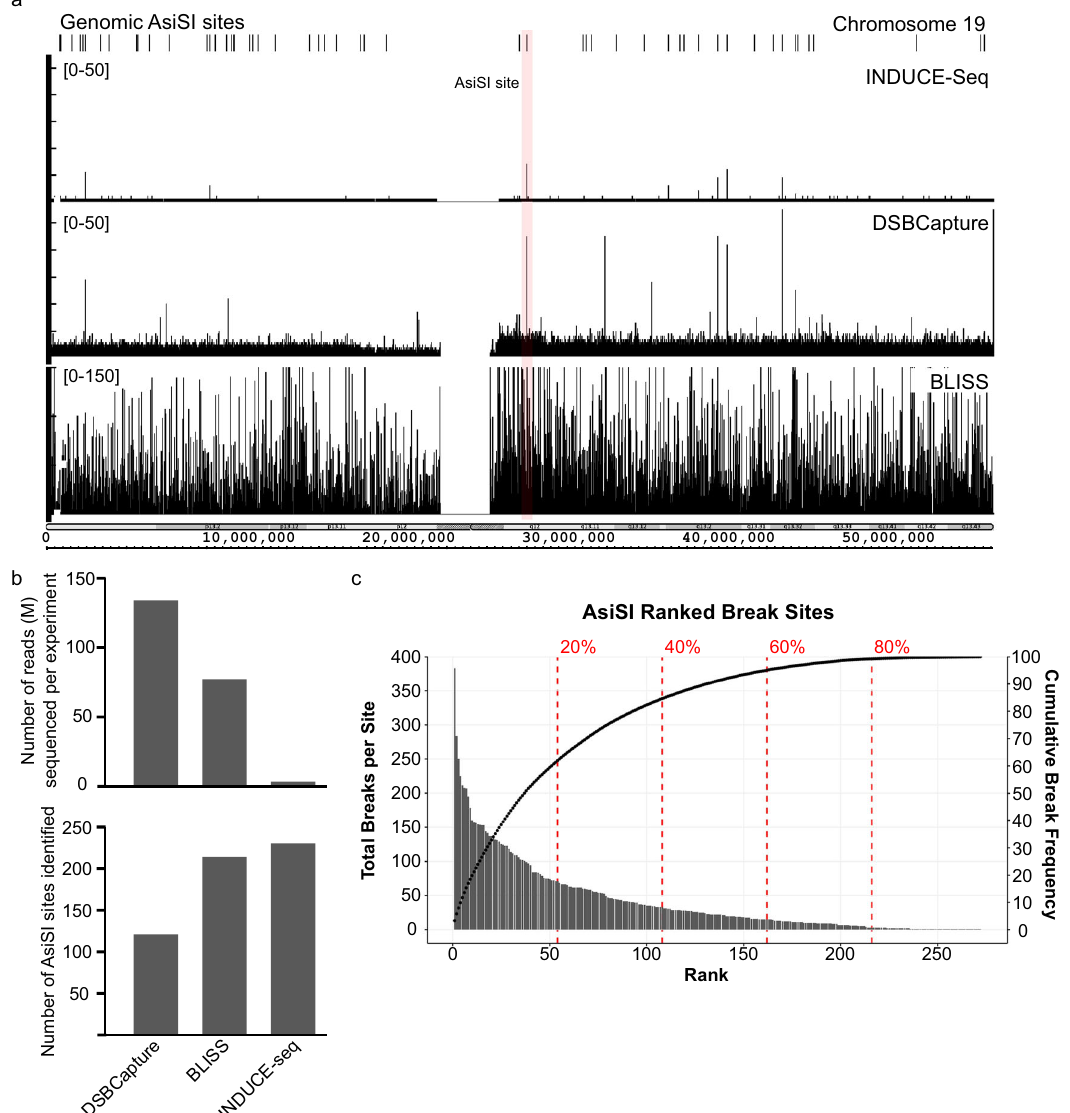
Fig. 3 INDUCE-seq reveals the characteristics of AsiSI site cleavage in live DIvA cells. a Genome browser view (IGB) comparing raw sequencing output of three different DSB capture methods used to detect induced breaks in live DIvA cells. The top panel indicates AsiSI recognition sequences present on chromosome 19. The second panel depicts the raw INDUCE-seq readout. The bottom two panels show the raw output of DSBCapture and BLISS. b Comparison between INDUCE-seq, DSBCapture and BLISS in detecting AsiSI-induced breaks in live DIvA cells. The number of reads sequenced ( b , top panel) is compared to the number of AsiSI sites identi fi ed in each experiment ( b , bottom panel). c AsiSI sites detected by INDUCE-seq ranked by break number. Total number of breaks were plotted at each of the 278 AsiSI restriction sites (primary y -axis). The cumulative break frequency at AsiSI sites was calculated and plotted as a percentage on the secondary y -axis. Source data are provided as a Source Data fi